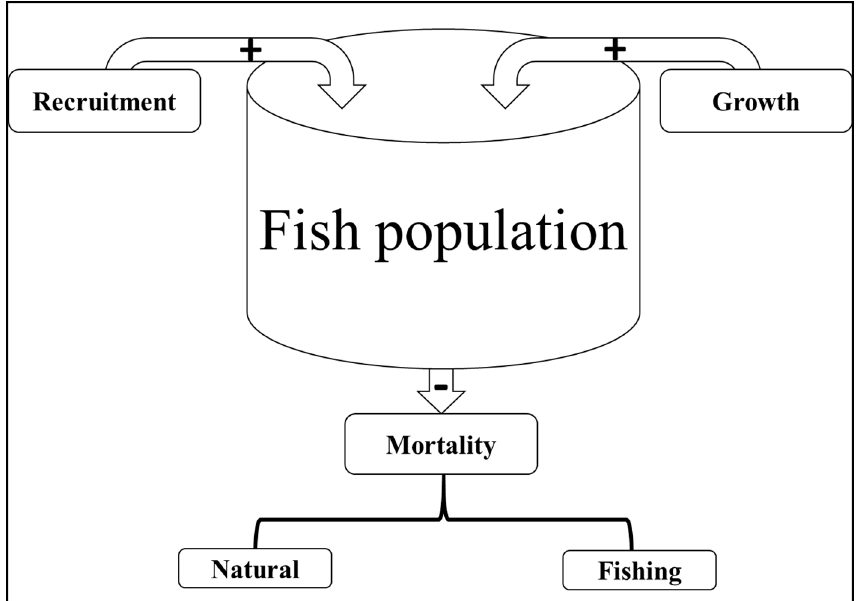
Figure 4. Illustration of the fish population dynamics. The “+” sign indicates an addition to the population, while the “–” sign indicates removal from the population.